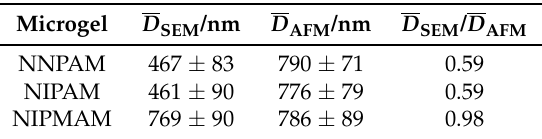
Table 1. Particle diameters obtained by AFM and SEM. Additionally, the relationship of the diameters to each other was